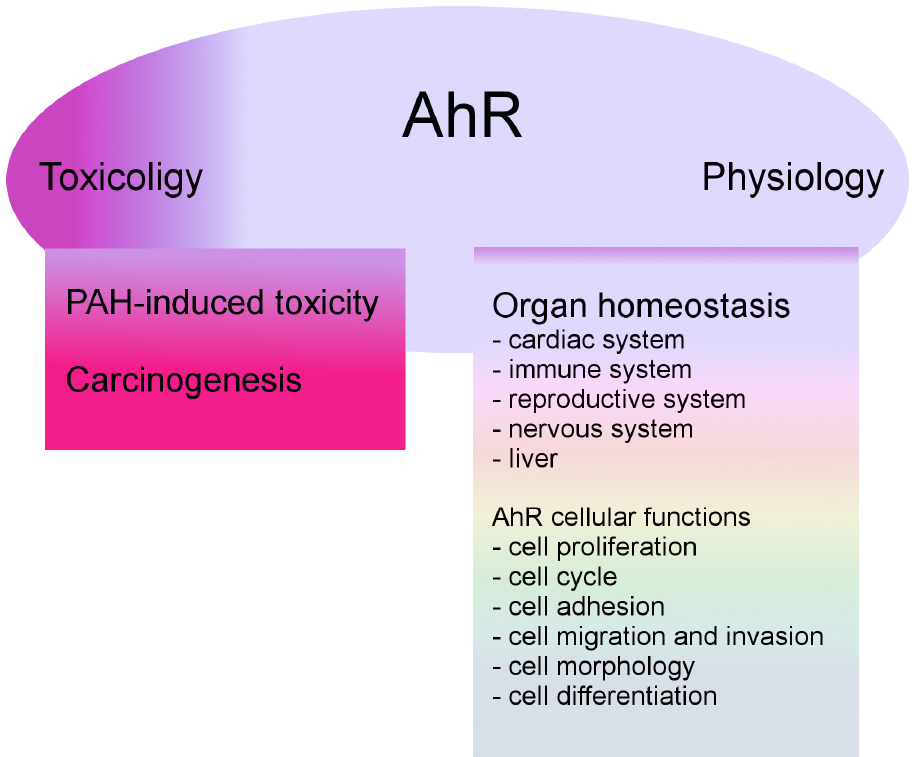
Figure 1. Integration of physiological and toxicological cellular functions by aryl hydrocarbon receptor (AhR). AhR plays an important role in toxicology, promoting the metabolism and elimination of toxic and carcinogenic compounds present in the environment. The AhR signaling pathway is also important in organ homeostasis and maintenance of critical cellular functions.